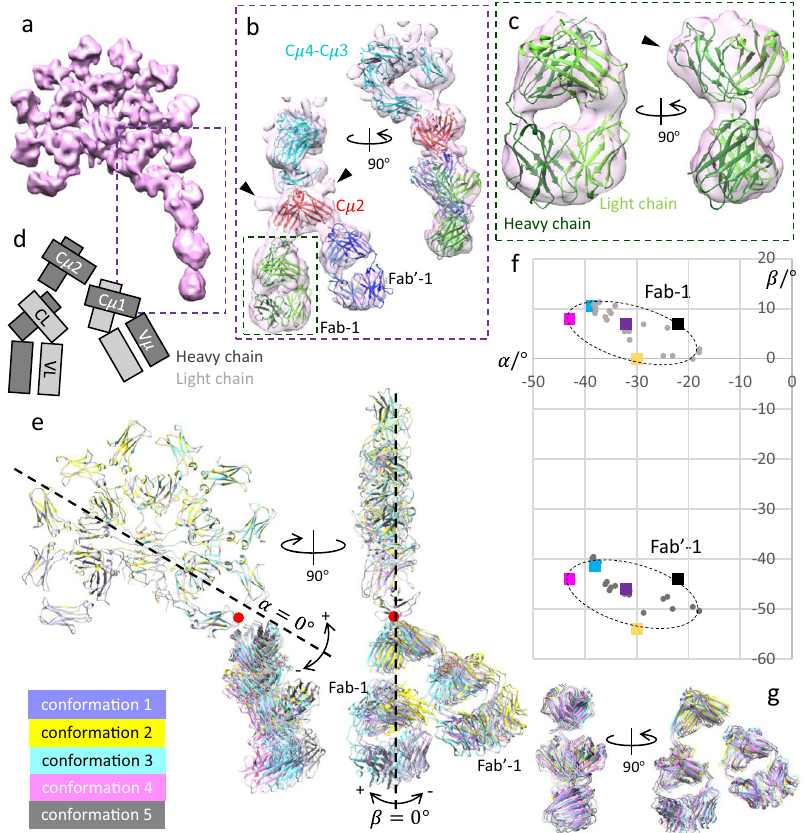
Fig. 3 | Structure of F(ab ’ ) 2 in subunit 1 and its fl exibility. a One of fi ve con- formations (conformation 4) classi fi ed from 3-D variability analysis